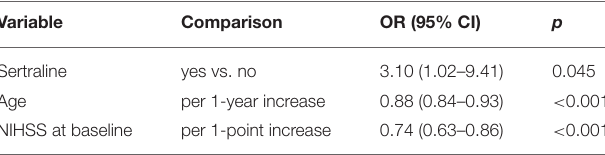
in the control group (8 [IQR 5–11] vs. 5 [IQR 4–7]; p = 0.002). TABLE 2 | Multivariable regression analyses of favorable functional outcome and post-stroke depression at 3